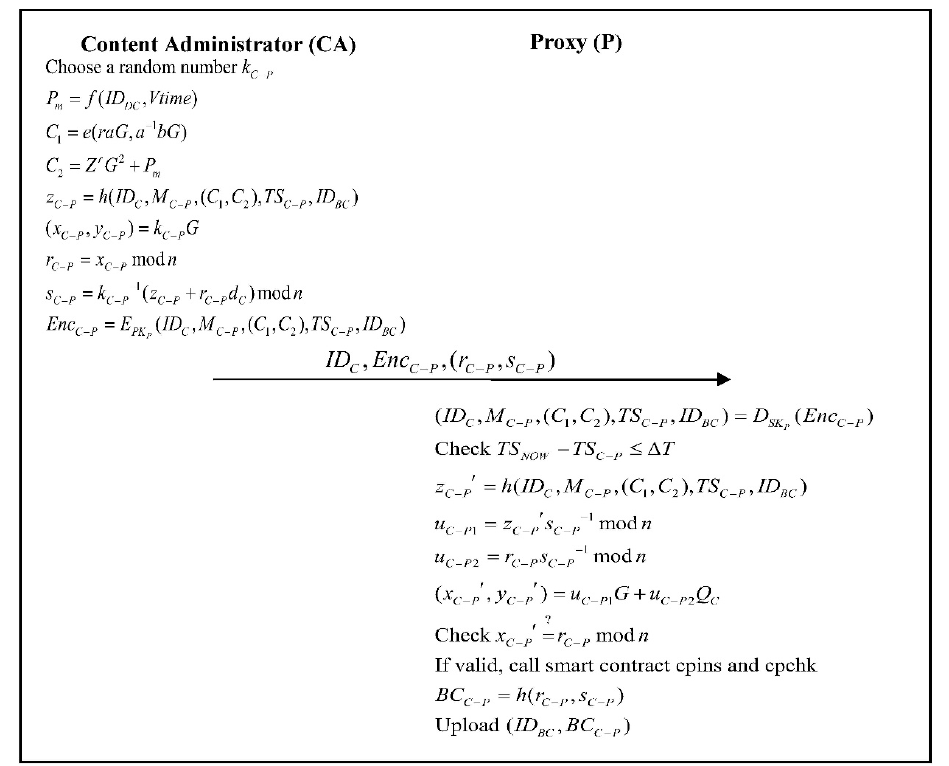
Figure 14. Payment verification and browsing phase (CA to P).